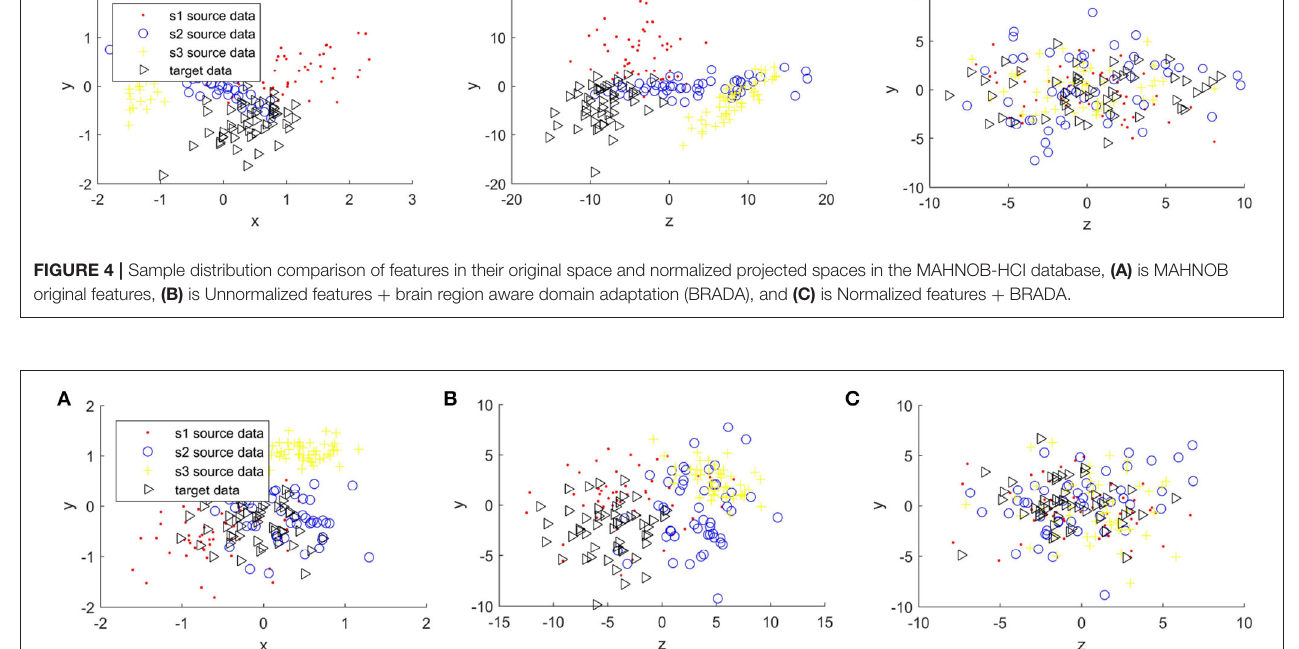
FIGURE 5 | Sample distribution comparison of features in their original space and normalized projected spaces in the DEAP database, (A) is DEAP original features, (B) is Unnormalized features + BRADA, and (C) is Normalized features + BRADA.